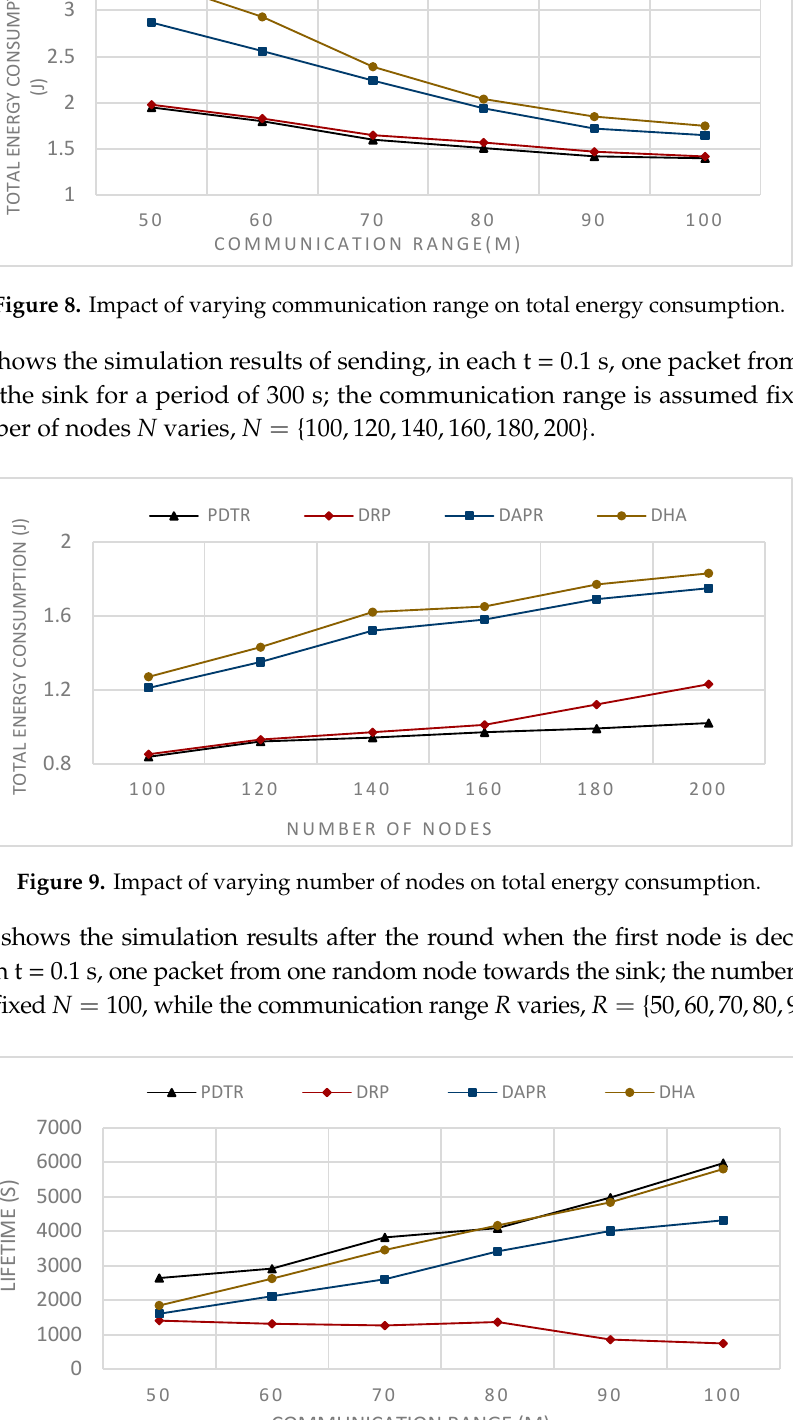
Figure 11. Impact of varying the number of nodes on the network lifetime.